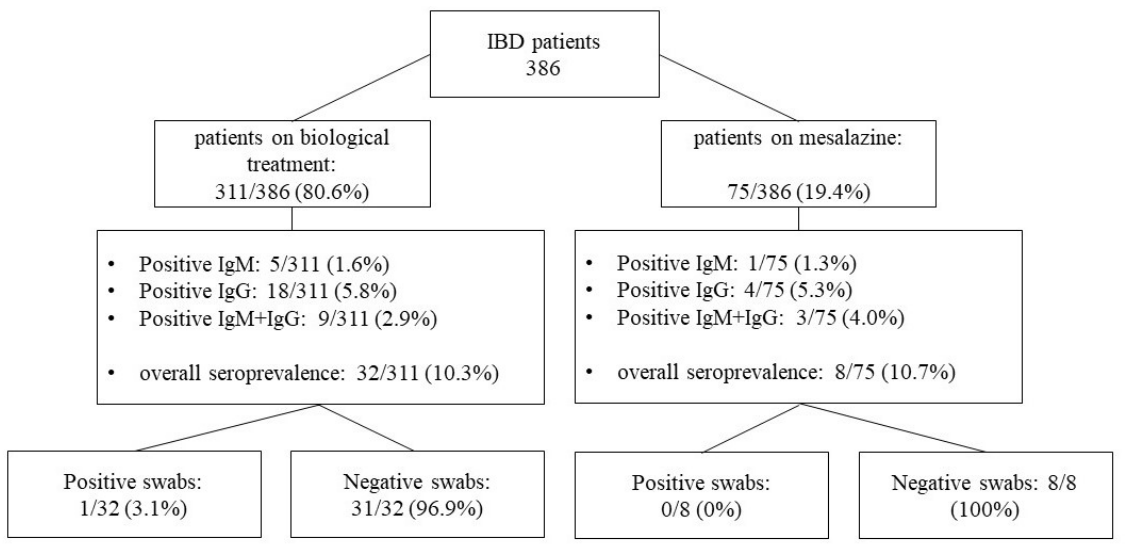
Figure 1. Seroprevalence analysis in IBD patients’ groups. The prevalence rate of SARS-CoV-2 serum antibodies in non-IBD healthcare profes- sionals was 13.0% and was not significantly higher than that of IBD patients on biological therapy (10.3%; p = 0.173) or in the total IBD patient population studied (10.4%; p = 0.145). Table 3. Univariate and multivariate analyses of variables associated with a positive antibody